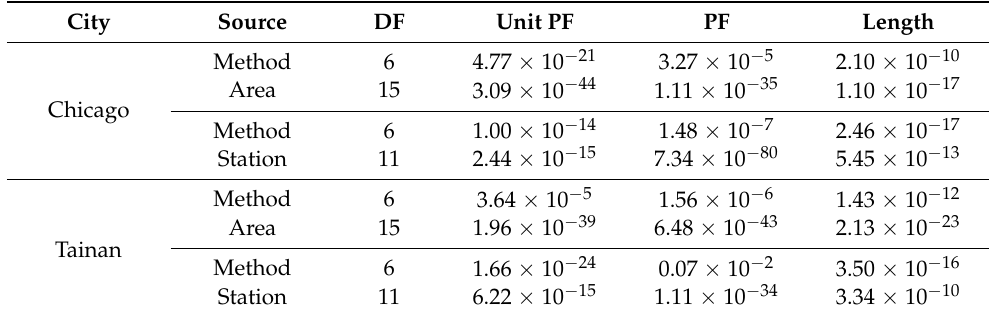
Table 8. p -Values in two-way ANOVA test for different methods towards all